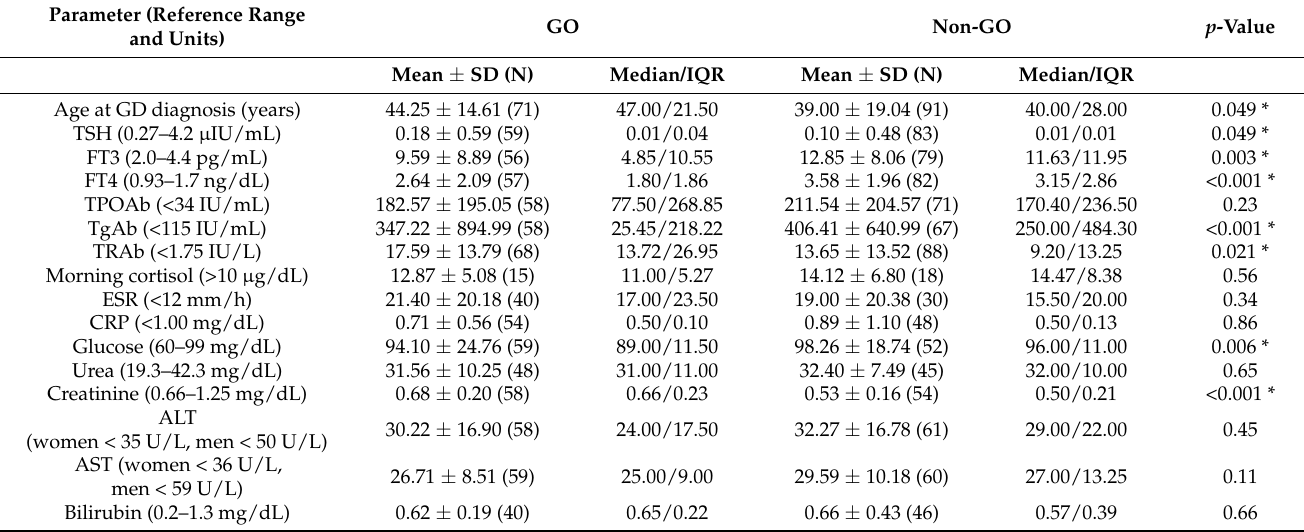
Table 1. Comparison of GO and non-GO groups in regard to patients’ age and laboratory results. Parameter (Reference Range and